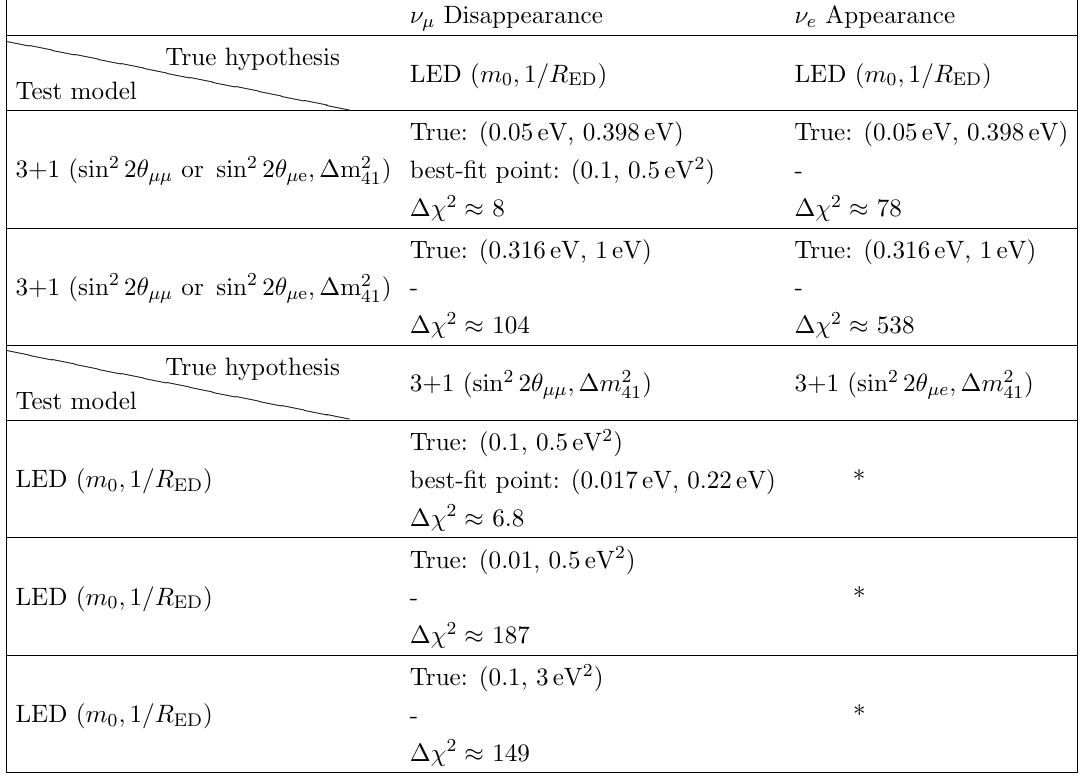
Table 2 . Discrimination power of SBN facility for 3+1 model and LED